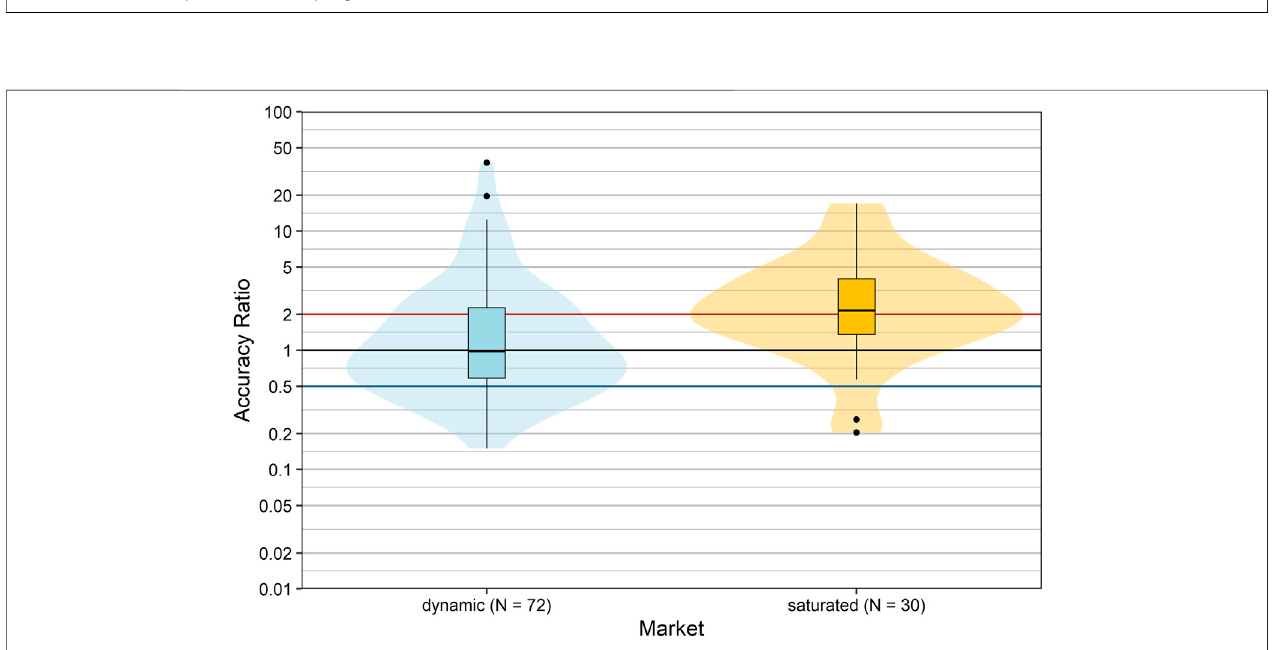
FIGURE3| Comparison accuracyratios groupedbydiseaseareas (ATCClassi fi cationLevel1). Boxplotsandviolinplotsshowaccuracyratiosofforecastedsales inthe3 yearsafterapositivereimbursementdecisiongroupedbydiseasecategory.Foreachdiseasecategory,themarketsituationofthemajorityofproductswithinthis disease category is indicated by different colors. ATC-L1 groups D, G, H, M, S, and V each contained only three or less products, and were combined into one “ Other ” category.Duetotheirasymmetricnature,accuracyratiosareplottedonalogarithmic(base10)scaletoavoidvisuallyoveremphasizingoverestimatescomparedto underestimates. Abbreviations: ATC, Anatomical Therapeutic Chemical; D, Dermatologicals; H, Systemic hormonal preparations, excluding sex hormones and insulins; M, Musculo-skeletal system; S, Sensory organs.